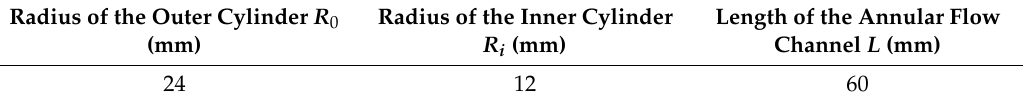
Figure 4. Representation of the annular flow channel with length L . R 0 is the radius of the outer cylinder; R i is the radius of the inner cylinder; r is annular flow thickness; inner diameter of annular ( R o + R ) − r and outer diameter of annular flow = 1 flow = 1 i 2 Annular flow channel of the partial pressure tool typical sizes are showed in Table 2. Table 2. Structural parameters of the annular flow channel.